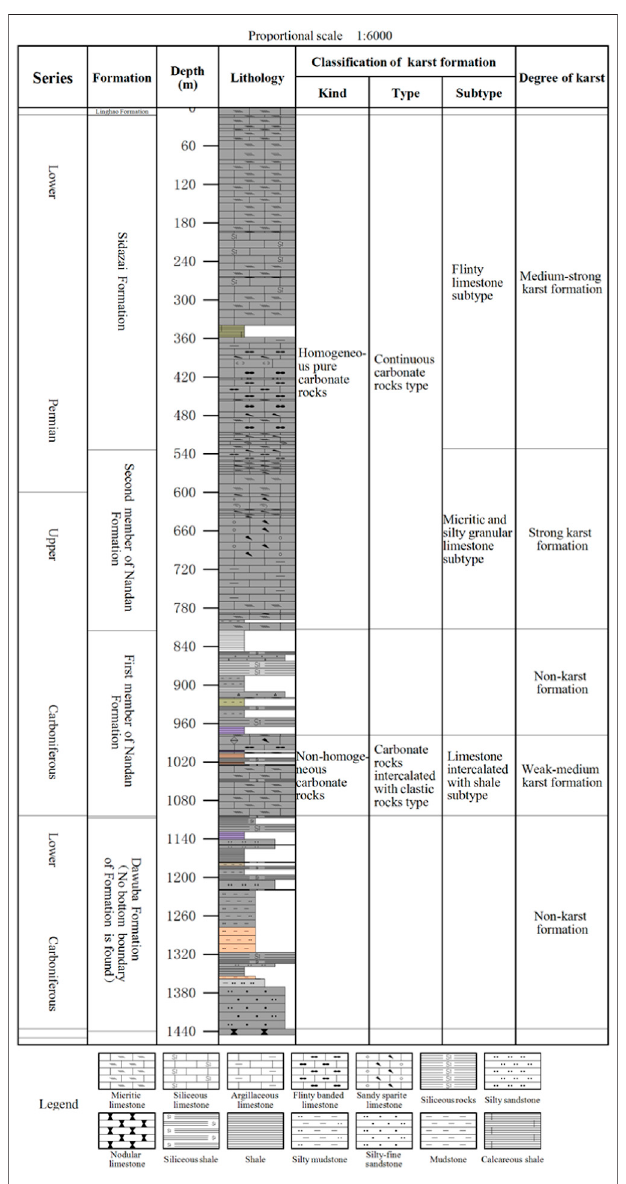
FIGURE 6 | Karst formation division of the Fengting section of Luodian, Qiannan area.